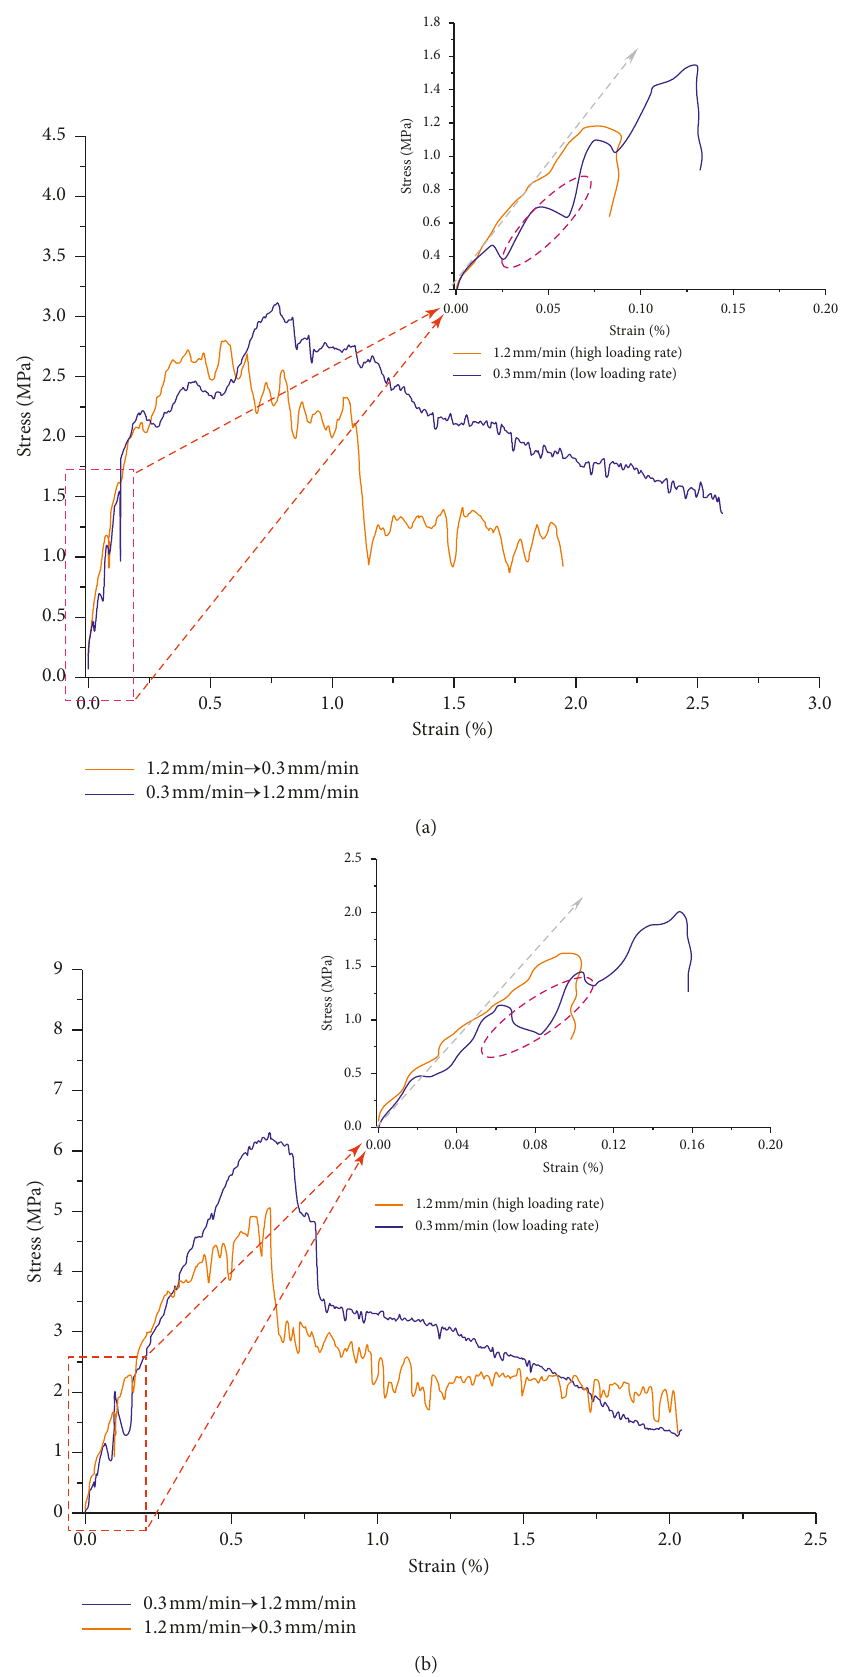
Figure 7: Stress-strain curves of the RCB(1 ∼ 2) specimen under combined loading rate: (a) RCB(1) specimen; (b) RCB(2)